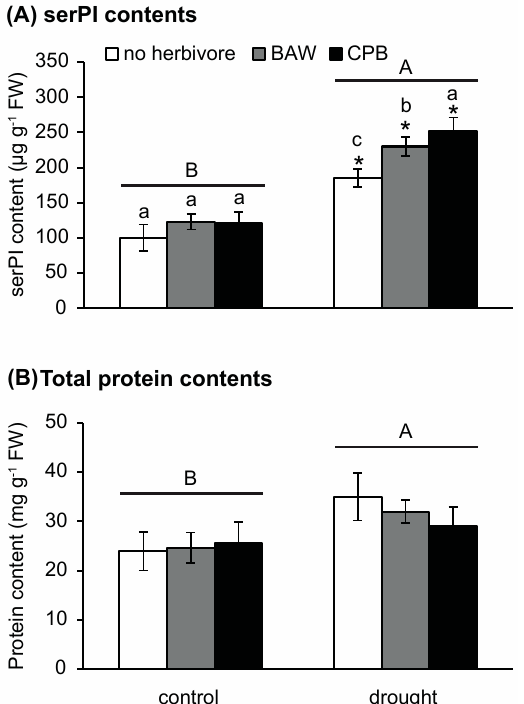
Figure 7. Effects of water availability and insect herbivory treatments on serine-type protease inhibitor ( A ) and leaf total protein ( B ) concentrations of Solanum dulcamara leaves. Plants were well-watered (control) or under drought treatment (drought) without herbivory (no herbivore, empty bars) or fed by Spodoptera exigua (BAW, grey bars) or Leptinotarsa decemlineata (CPB, black bars). Different capital letters (A or B) indicate the significant main effects of watering treatments ( p < 0.05). Different small letters (a, b, c) within each watering treatment indicate significant differences between herbivory treatments. * p < 0.05 obtained from Student’s t -tests between well-watering and drought treatments for each insect herbivory group. Error bars are standard errors, n = nine per treatment combination. serPI, serine-type protease inhibitor.